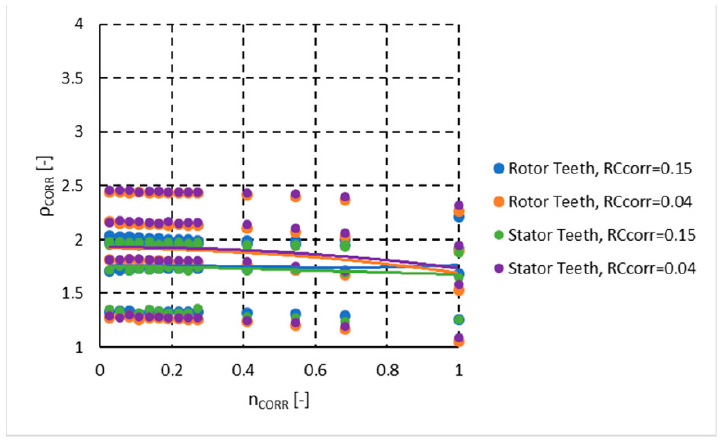
Figure 13. Kinetic energy trendlines.